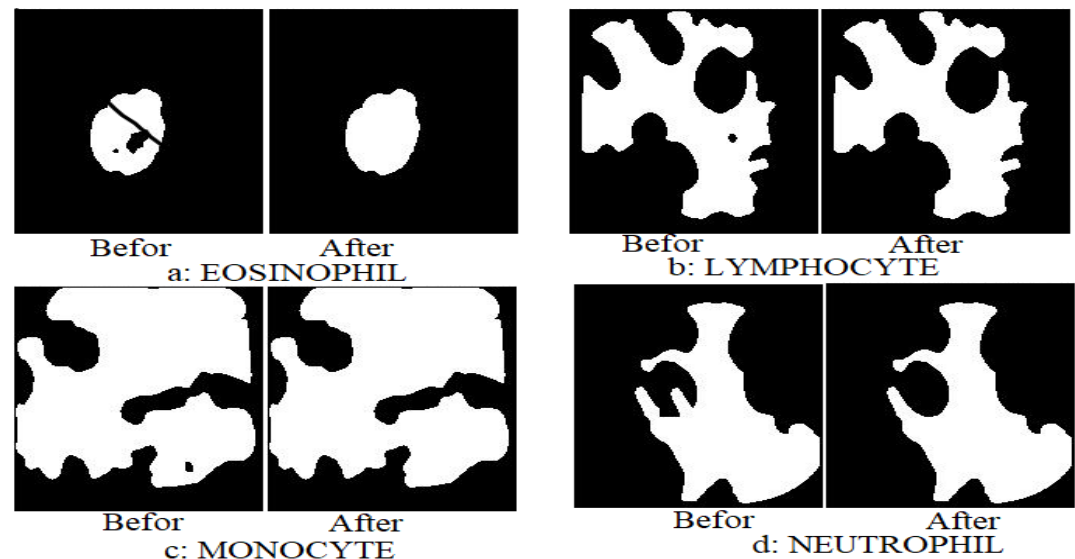
Figure 5. Some images in the dataset that were produced using the morphological algorithm.